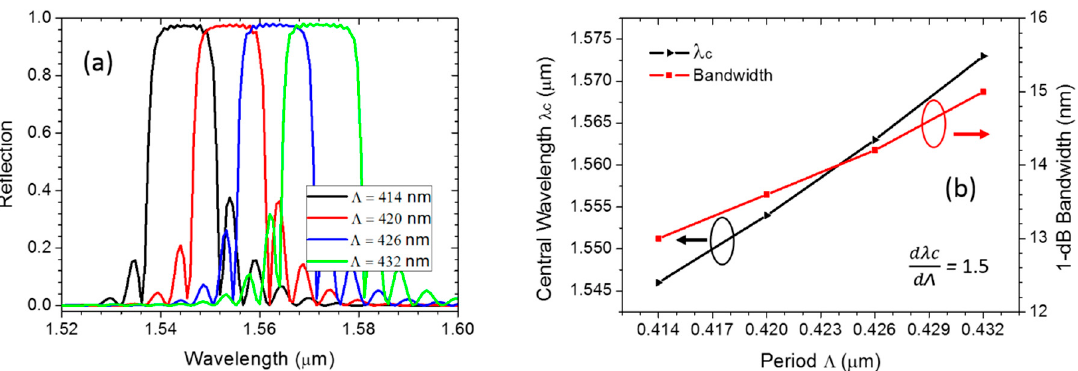
Figure 6. ( a ) The reflection spectra of linearly tapered MWG with different period ᴧ . ( b ) The central wavelength λ c and bandwidth (90% CE) as a function of grating period ᴧ at wavelength of 1.546 μ m.